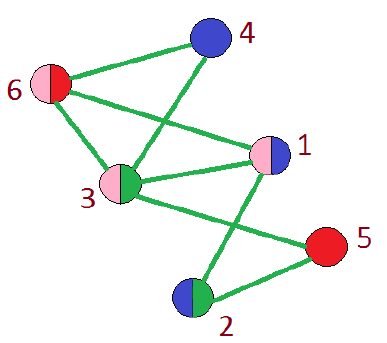
Figure 11. Represents participation of a user in more than one